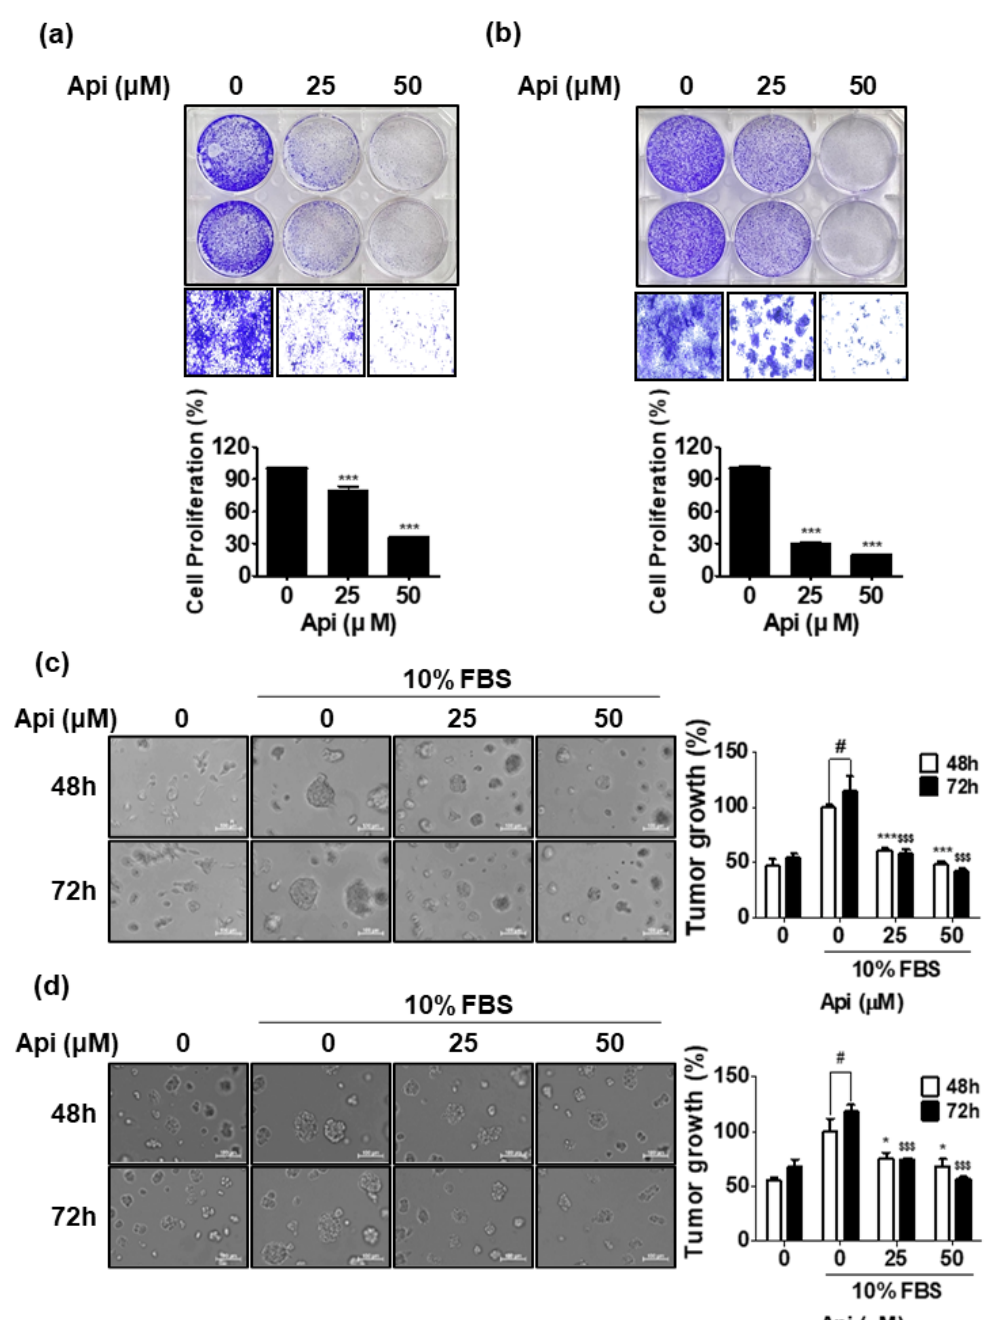
increased by 14.3% at 72 h compared with that at 48 h (Figure 2c). PC ‐ 3 spheroid growth rate increased by 18.1% at 72 h compared with that at 48 h (Figure 2d).